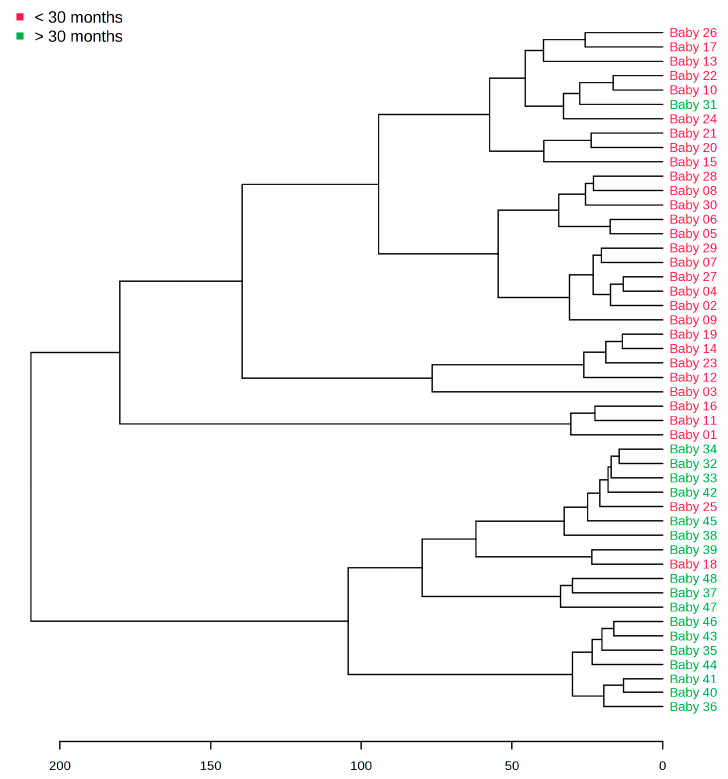
Figure 4. Dendrogram demonstrating the clustering of children < and >30 months of age.